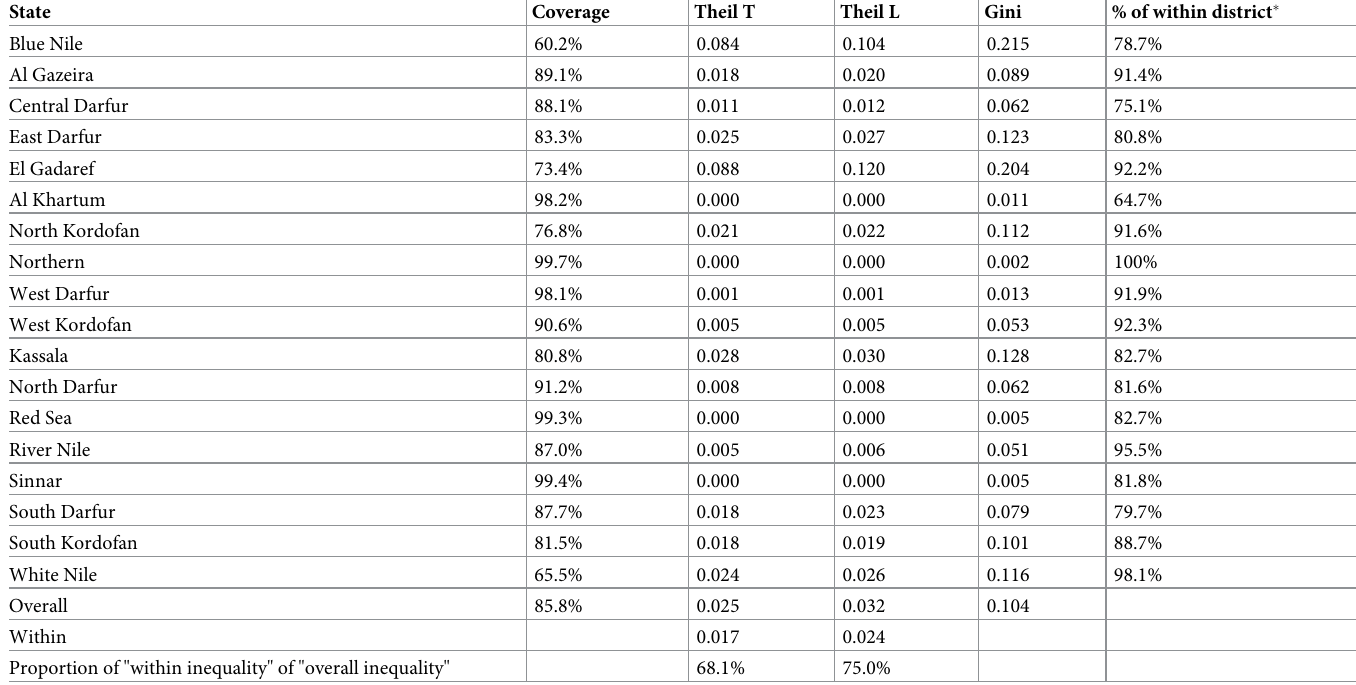
Table 2. Coverage of improved water at the household